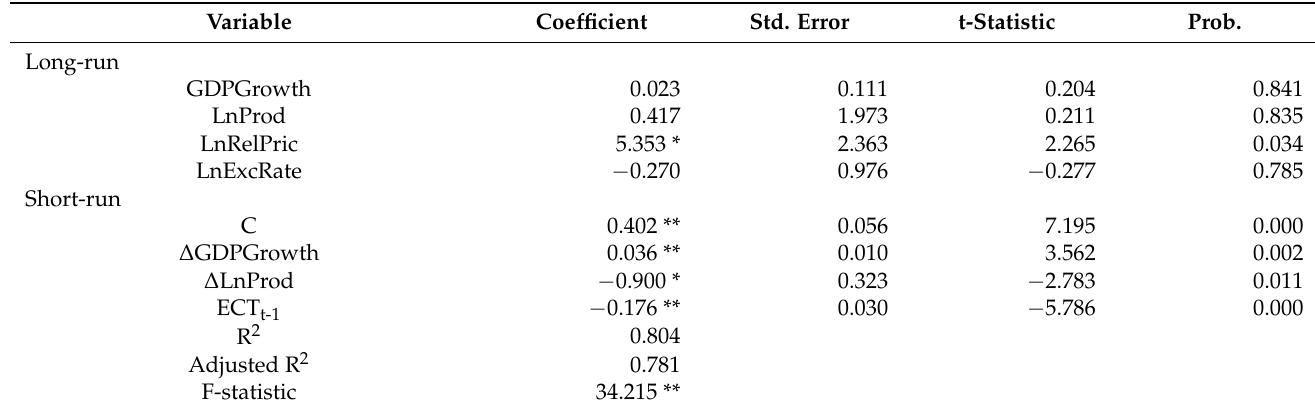
Table 7. The results of long-run and short-run ARDL import demand